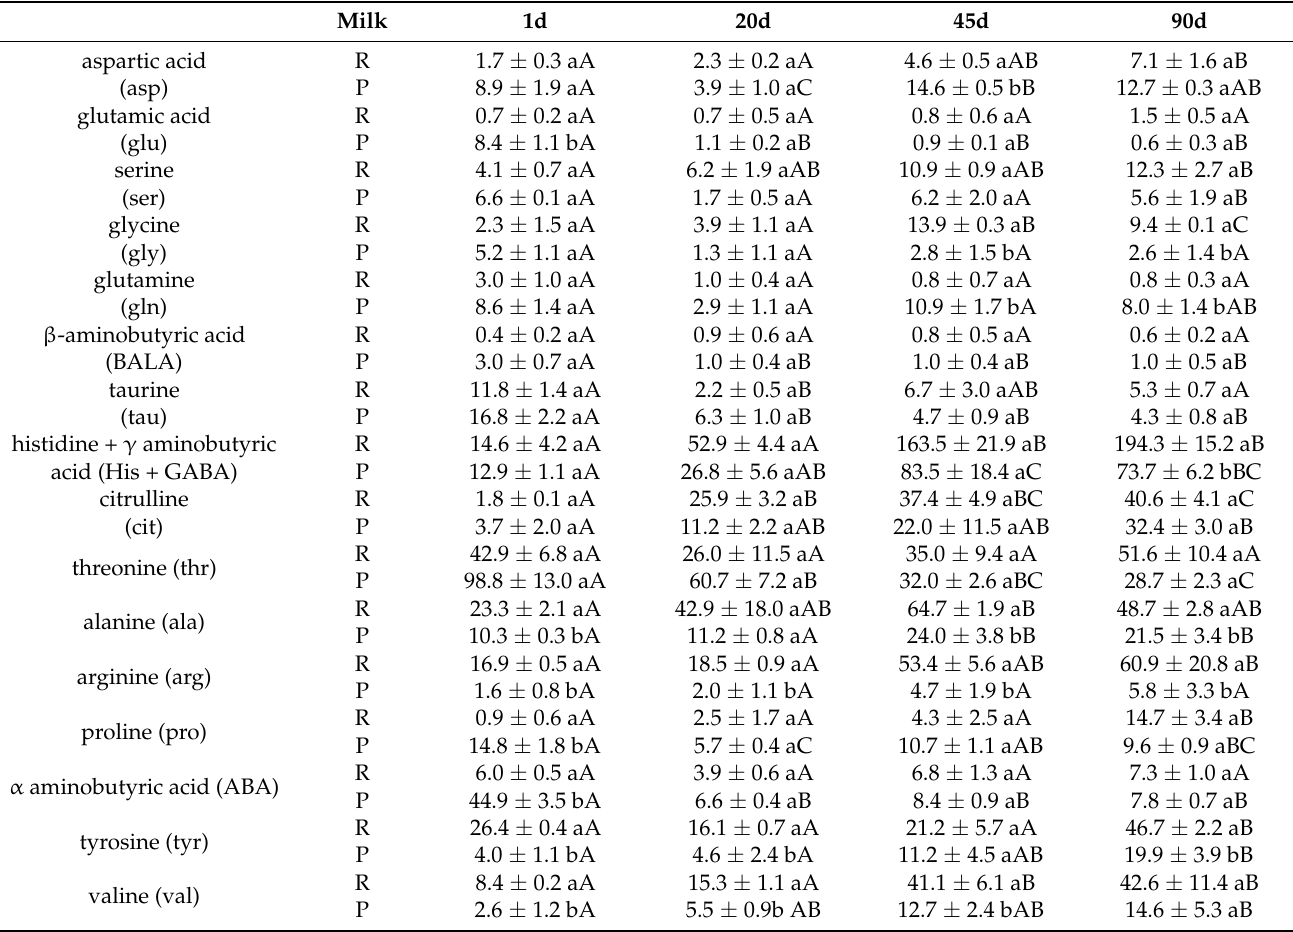
Table 6. Free amino acid content (mg/100 g of dry matter) of hard Xinotyri cheese made from raw (R) or pasteurized milk (P) during ripening and storage (i) .